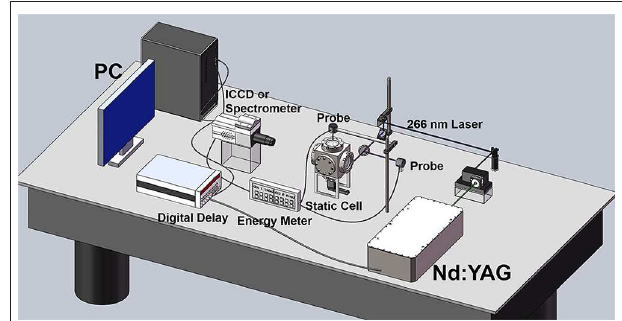
FIGURE 1 | Schematic diagram of Stern–Volmer coefficient measurement experiment.